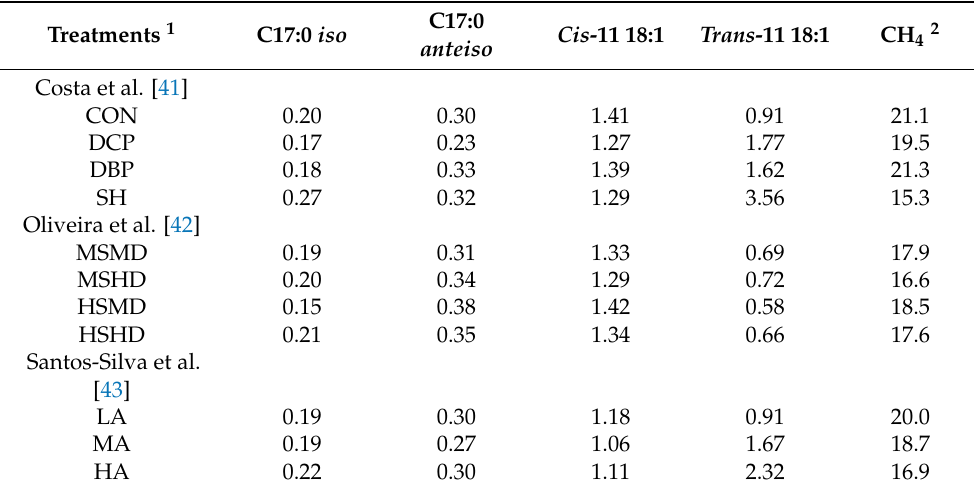
Table 5. Intramuscular FA contents and calculated methane production (CH 4 , g/d) of lambs allocated to several experimental treatments in the studies of Costa et al. [41], Oliveira et al. [42] and Santos- Silva et al. [43]. Data expressed as g per 100 g of total fatty